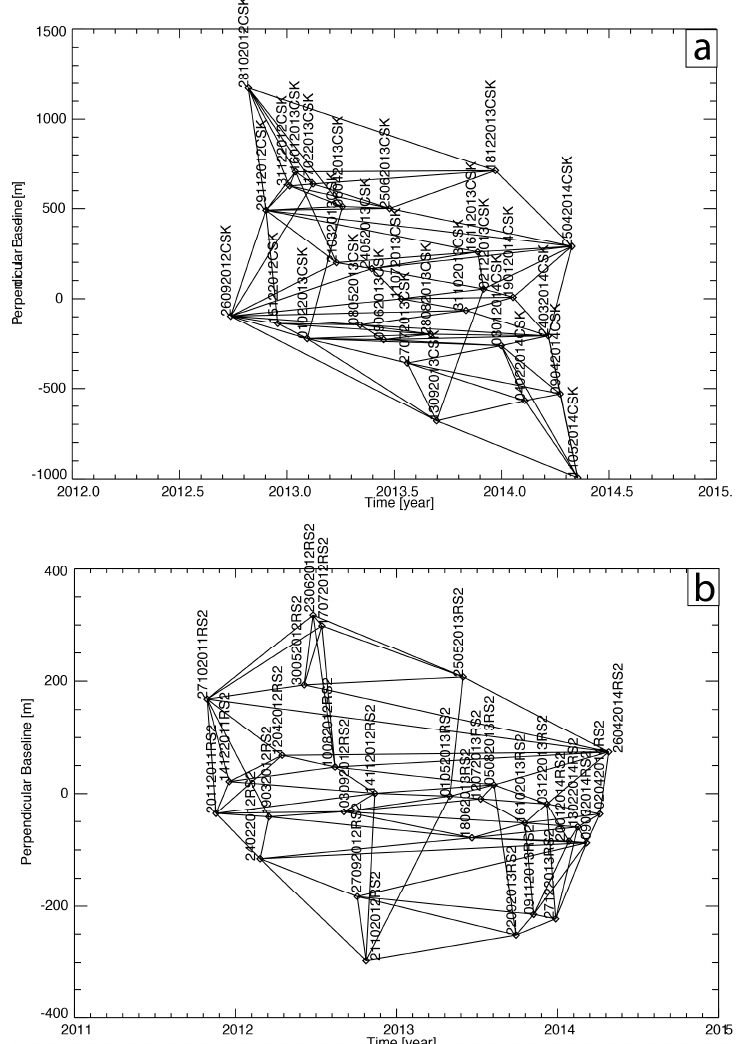
Figure 2. Synthetic Aperture Radar (SAR) data representation in the temporal/perpendicular baseline plane for the COSMO-SkyMed ( a ) and RADARSAT-2 ( b ) datasets. Each black triangle represents